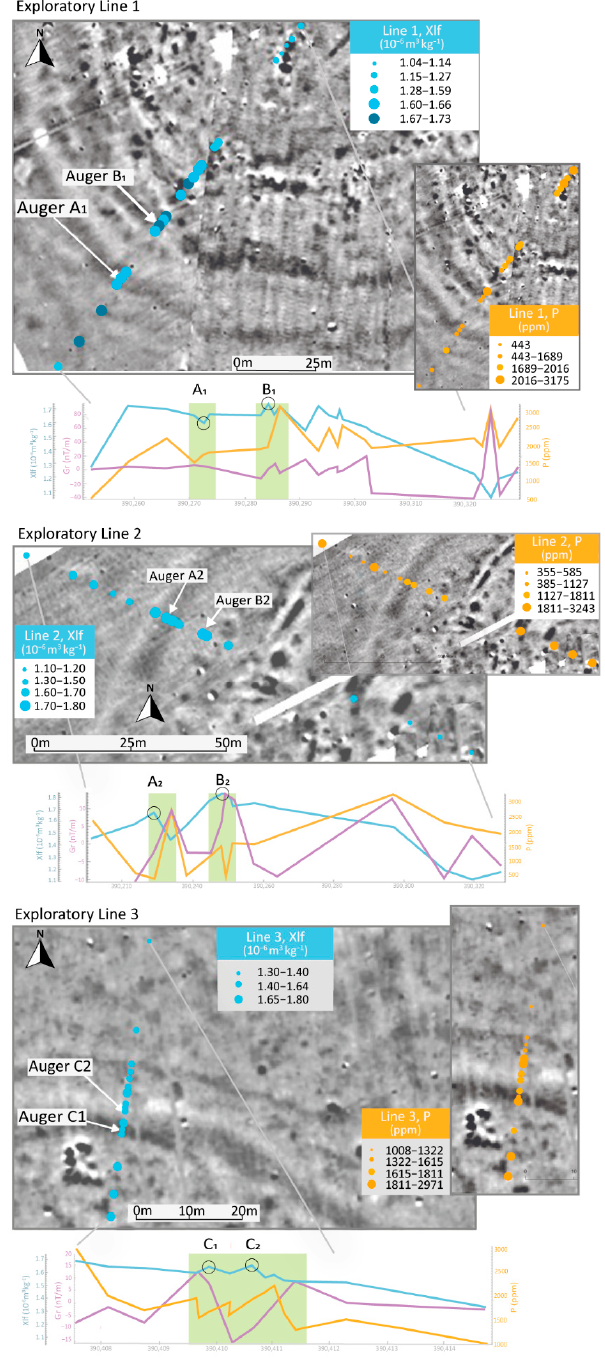
Figure 3. Bubble plots (overlying the magnetometer survey results) showing the lateral low frequency magnetic susceptibility ( χ lf, in blue) and phosphate (P, in orange) distribution along the exploratory lines at Rizomilos, overlying the magnetometer survey results. The grayscale image shows positive magnetic anomalies in black and negative anomalies in white. The grayscale image is shown at 70% opacity of Figures 1 and 2 to facilitate visualization of the bubble plots. The x–y graphs also show the lateral variation of the χ lf (blue line) and P (orange line), including the magnetic-gradient intensity (Gr, purple line). In the graphs, the location of the two targeted ditch-like positive magnetic anomalies is indicated in green (A = outer and B = inner). The location of the in-depth augered points is indicated as reference for Figure 4, where the in-depth results are shown. The location of the lines is shown in Figure